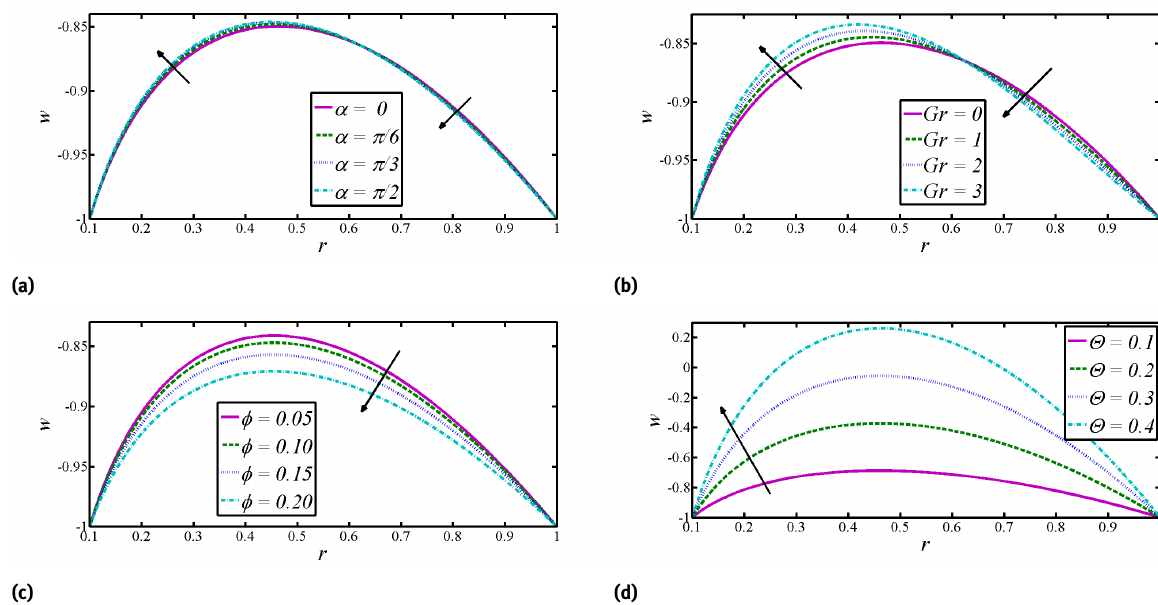
Fig. 3: The axial velocity profile for various fluid parameters.